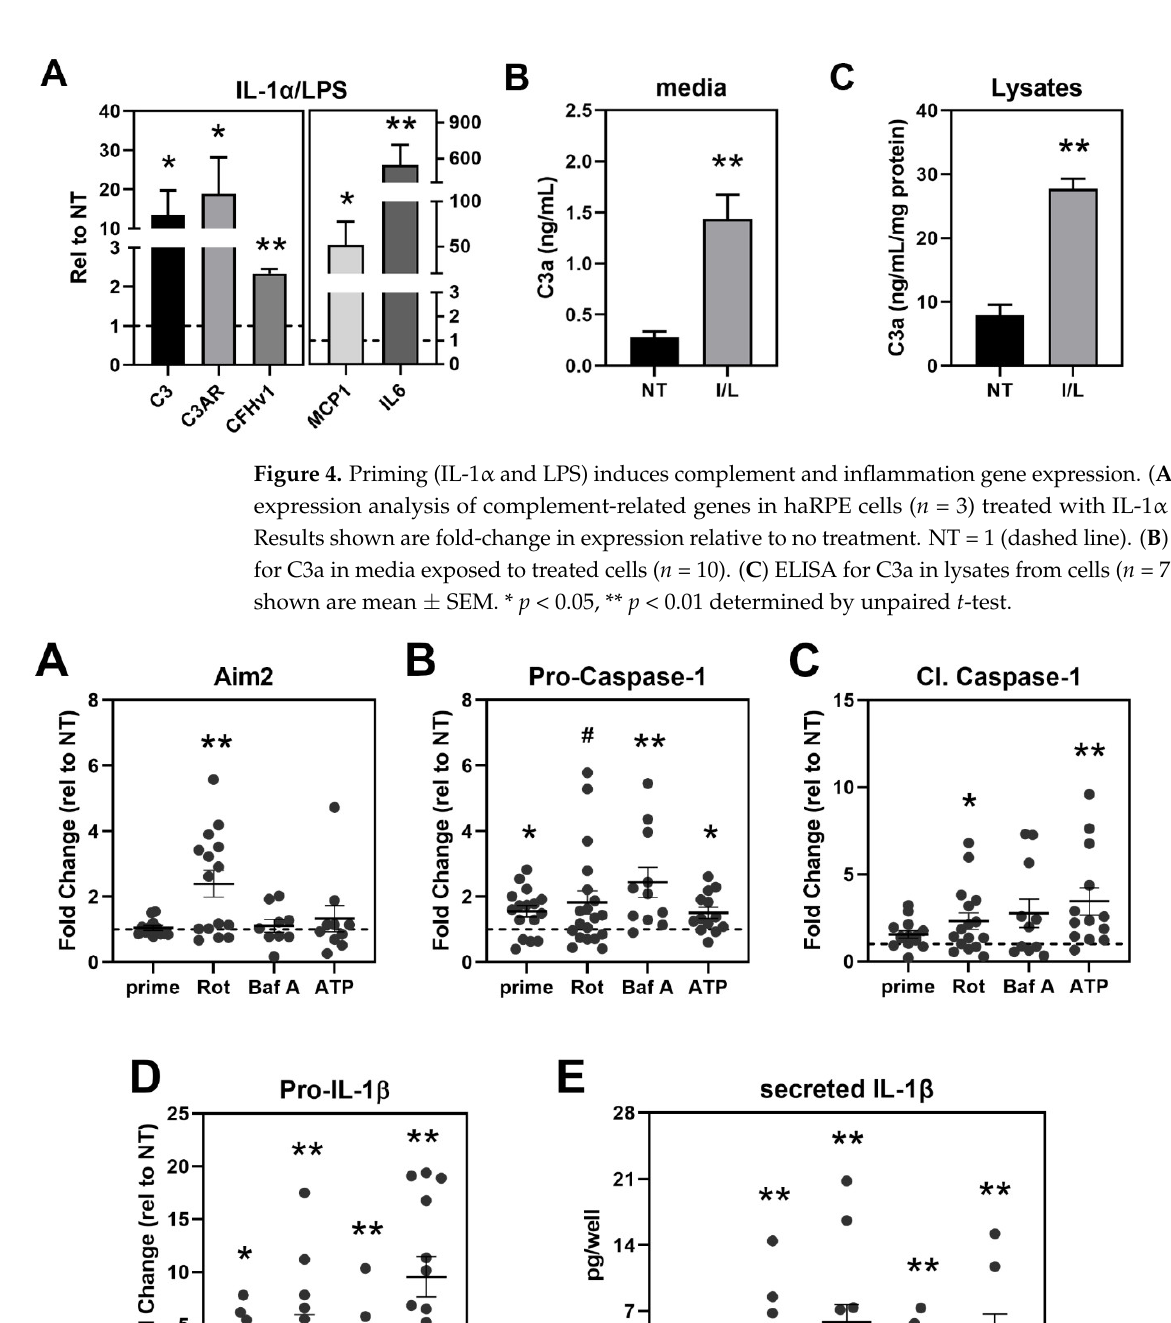
LPS and then treated with rotenone, Bafilomycin A, or ATP, to activate inflammasomes.